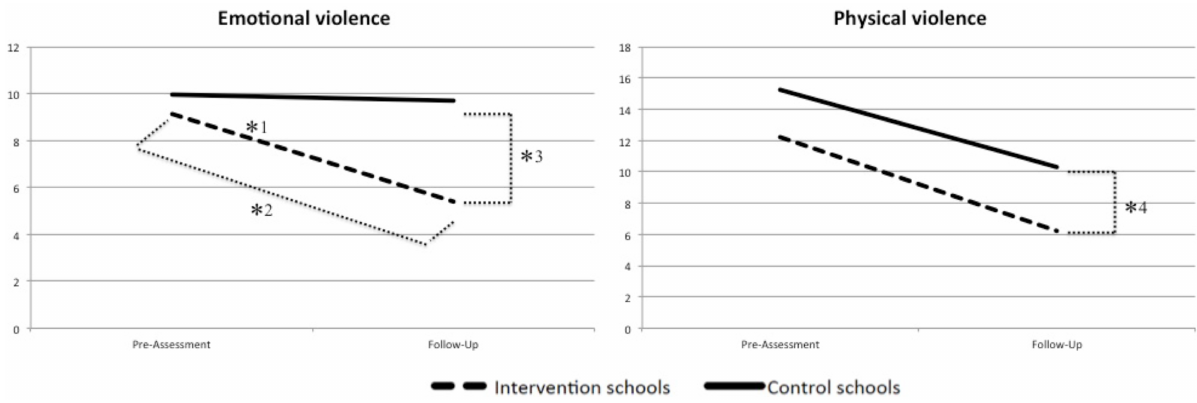
Fig 3. Exposure to emotional and physical violence reported by students in intervention and control schools at pre-assessment and follow-up assessment. (cid:3) 1 significant interaction effect, (cid:3) 2 significant decrease from pre-assessment to follow-up in intervention group, (cid:3) 3 significant difference between intervention and control schools at follow up, (cid:3) 4 significant difference between intervention and control schools at follow up (after controlling pre-assessment scores).